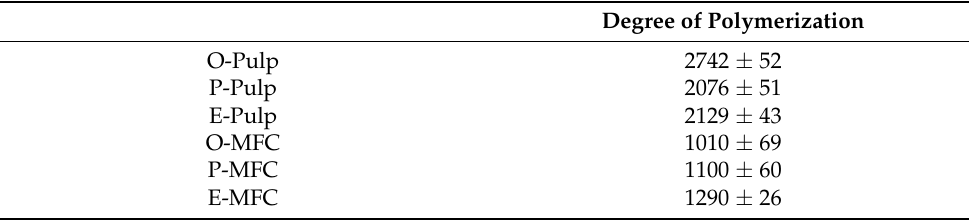
Table 2. Degree of polymerization of the different pulps and their corresponding MFCs.